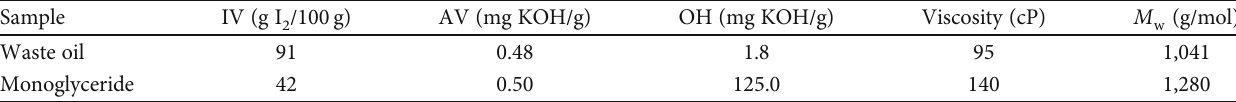
Table 2: Properties of waste oil and the as-prepared monoglyceride.